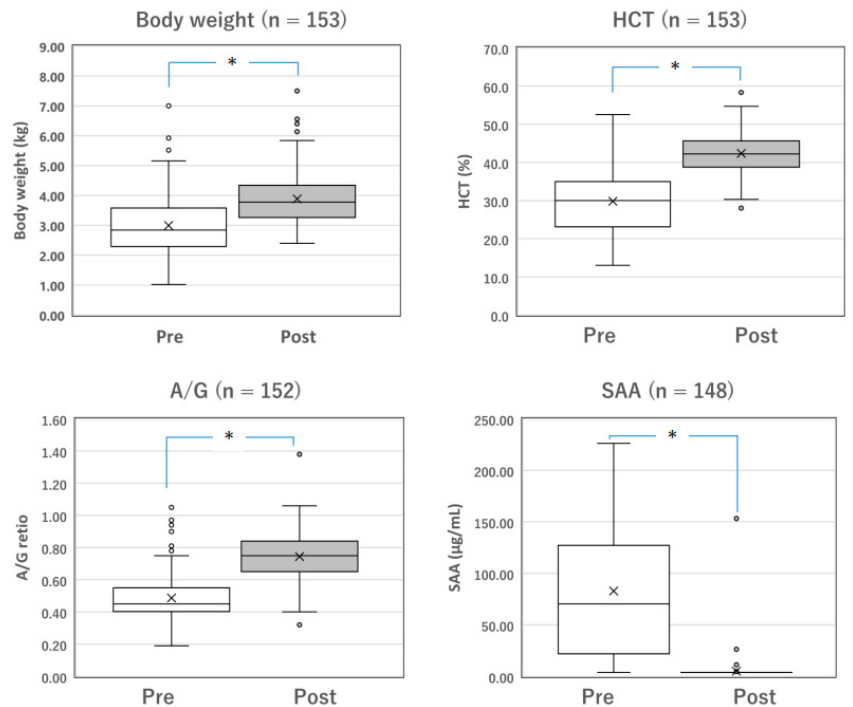
Figure 2. Changes in the parameters of surviving cats with dry FIP before and after Mutian treat- ment. The body weight, HCT, and A/G of the surviving cats were significantly improved after Mu- tian therapy (Post) compared with their values at the initial examination prior to drug therapy (Pre) ( * p < 0.0001). In contrast, SAA levels were drastically decreased after therapy ( * p < 0.0001). The ‘×’ and the horizontal line in the box represent the mean and median, respectively. The median divides the box into interquartile ranges, and the box represents 50% of the data set, distributed between the 1st and 3rd quartiles. The whiskers show the outlier range outside the upper and lower quartiles. Open circles denote outliers. All statistical analyses were performed using the Wilcoxon signed- rank test (non-parametric). HCT, hematocrit; A/G, albumin-to-globulin ratio; SAA, serum amyloid-